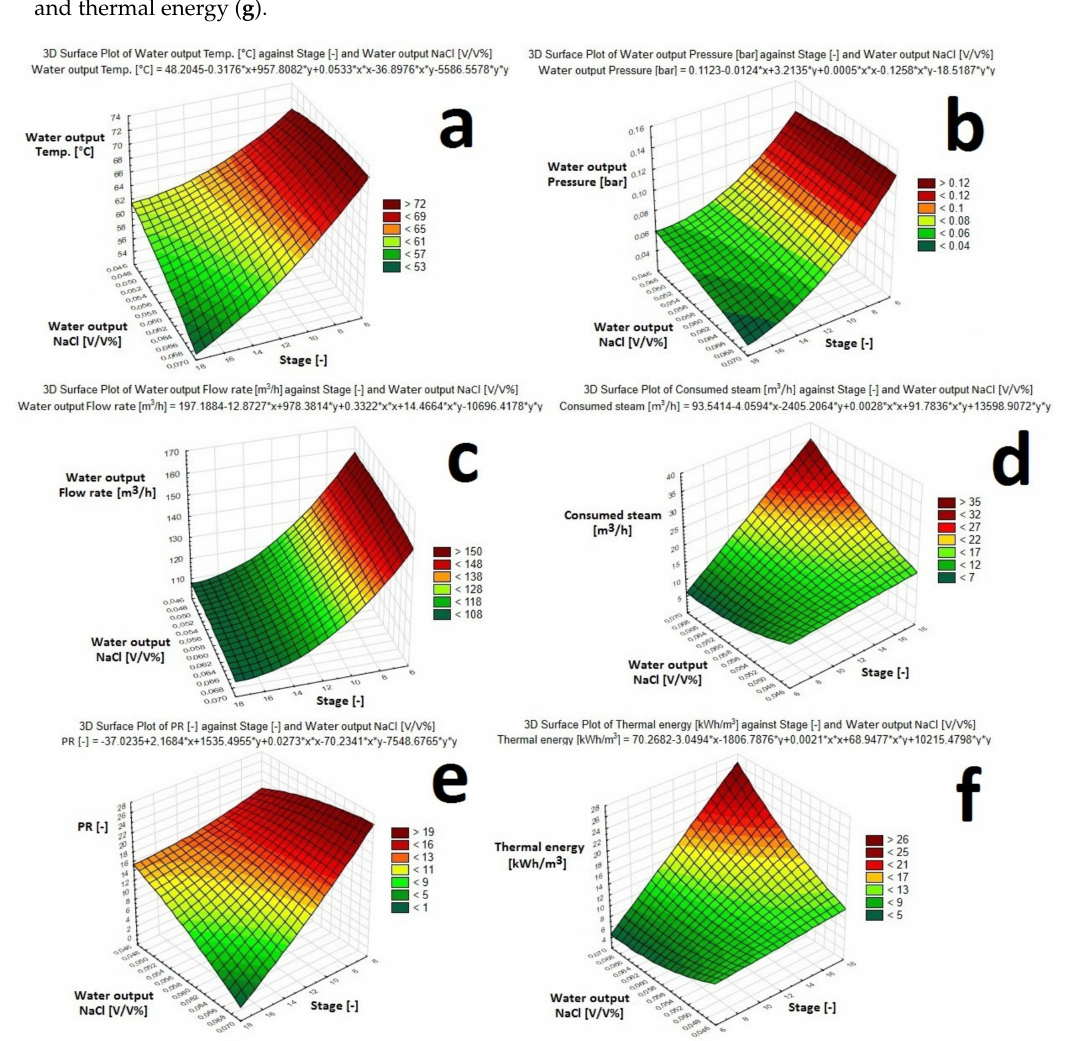
Figure 9. Influence of the number of Stages and Water output NaCl [V / V%] on the Water output Temperature ( a ), Water output Pressure ( b ), Water output Flow rate ( c ), Consumed steam ( d ), Performance ratio ( e ), and Thermal energy ( f